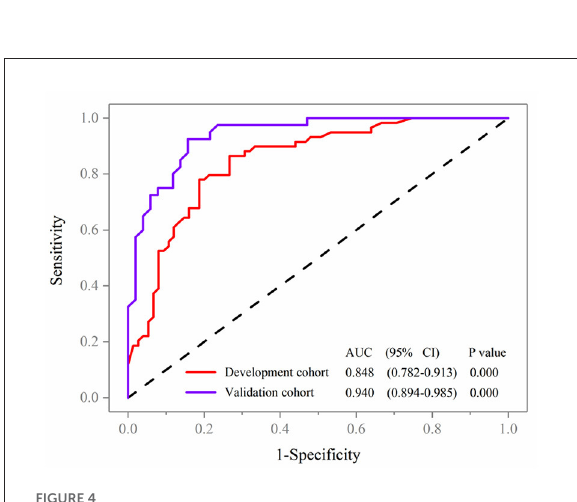
FIGURE4 Receiver operating characteristic curve analyses of prediction for MCI in the development and validation